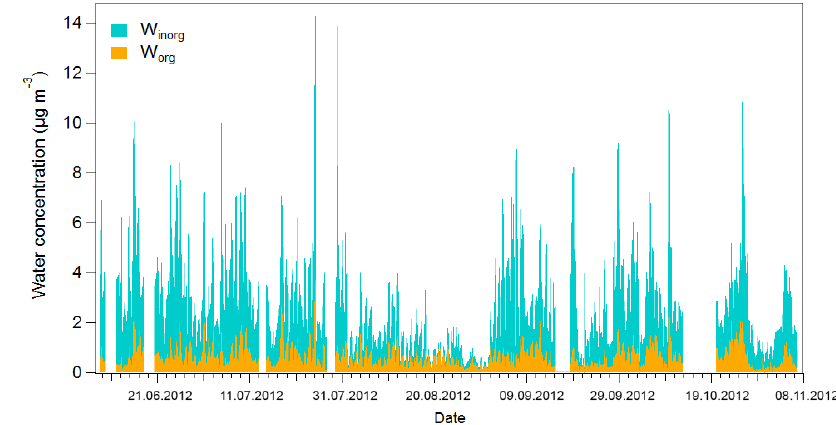
Figure 2. Time series of the two calculated aerosol water components, the water associated with the inorganic ( W inorg ) and the organic ( W org ) aerosol